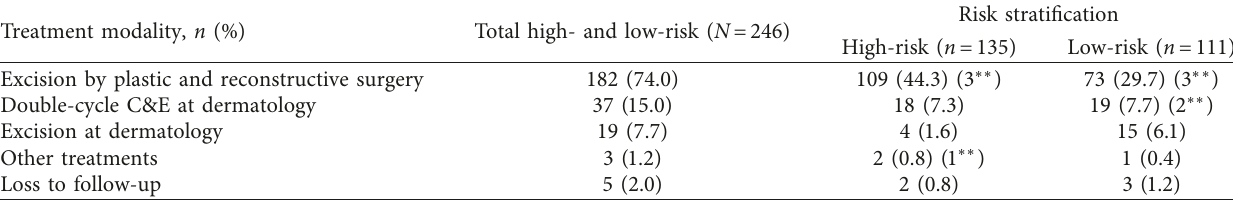
Table 3: NCCN risk stratification and final treatment modalities for BCC lesions ( N � 246). Treatment modality, n